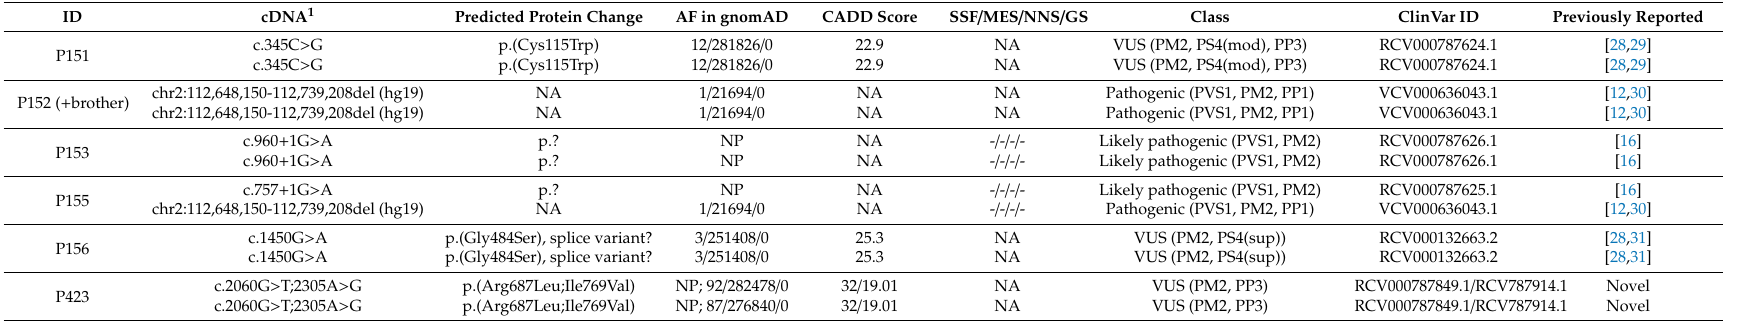
Table 2. Molecular genetic findings in